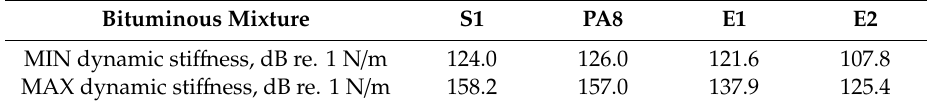
Table 2. The extreme dynamic sti ff ness values in the 10–1000 Hz band—the first stage. Bituminous Mixture